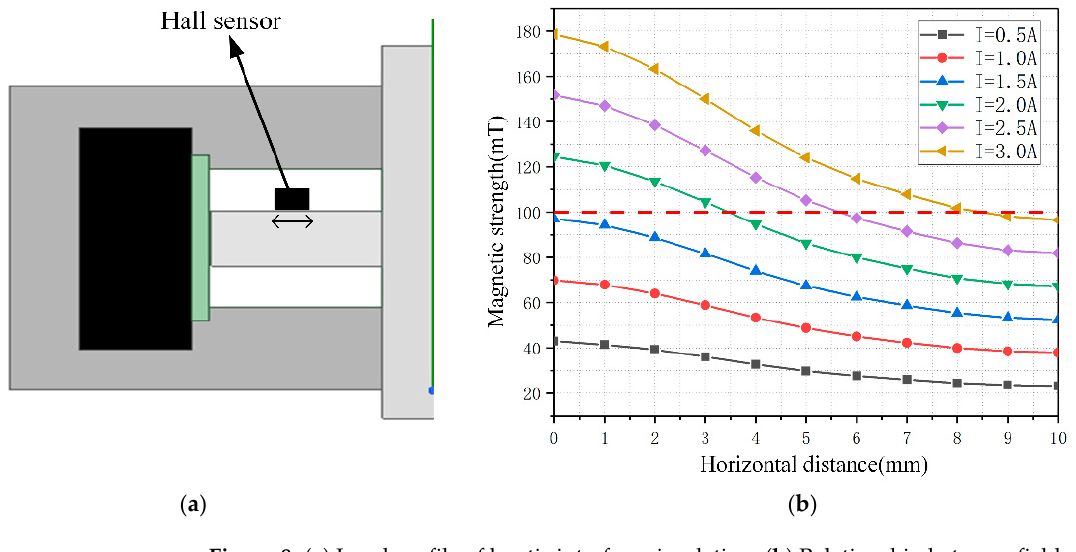
Figure 8. ( a ) Local profile of haptic interface simulation. ( b ) Relationship between field strength and horizontal displacement of recording points.